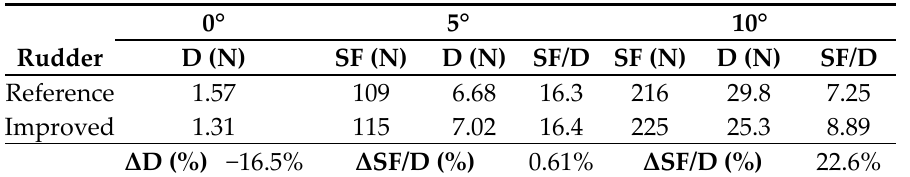
Table 1. CFD simulation